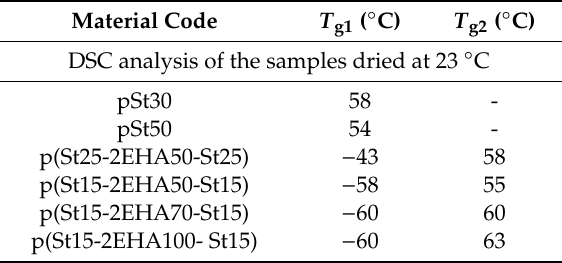
Table 2. Thermal properties of the pSt and p(St-2EHA-St) block copolymers obtained by DSC. Material